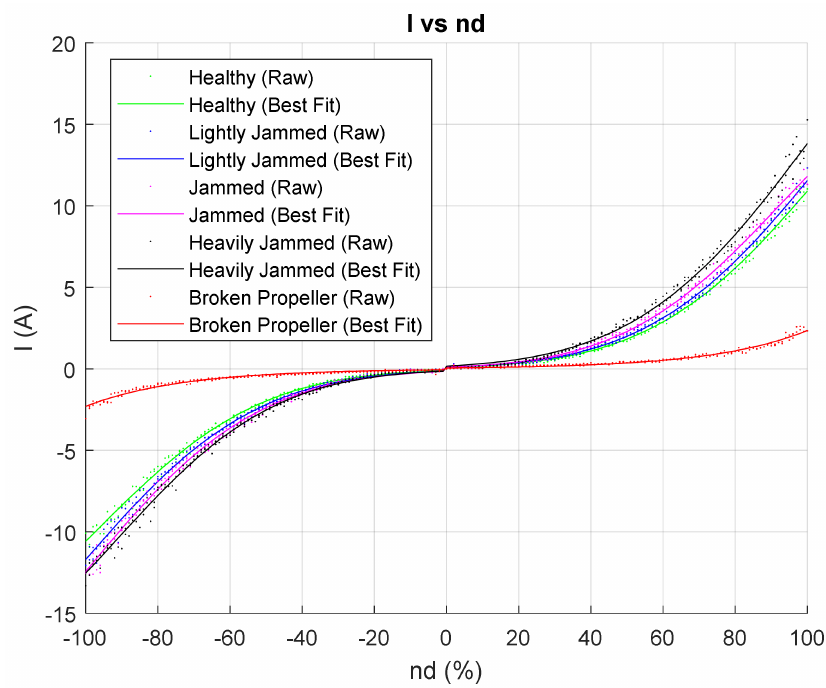
Figure 6. Diagrams of raw & best fit training data: I versus n d